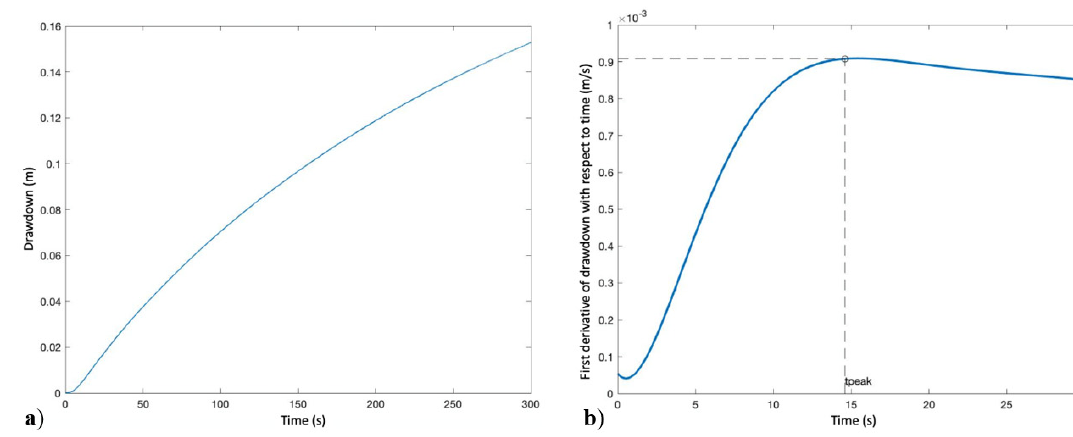
Figure 10. ( a ) Simulated drawdown curve at the observation point in well M and ( b ) the first derivative of drawdown with respect to time.